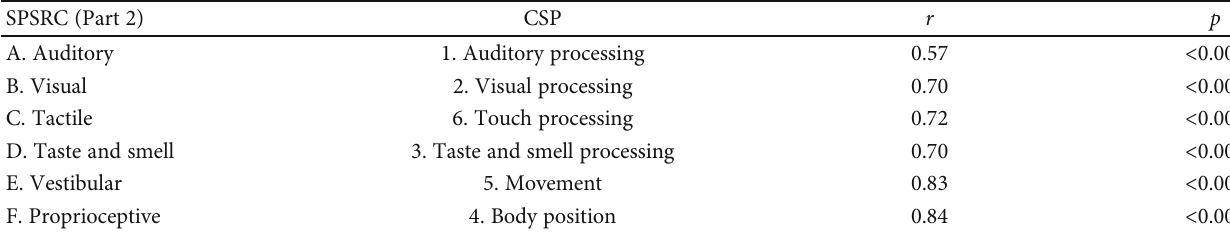
Table 1: Correlations between sensory domain scores of the SPSRC and CSP.